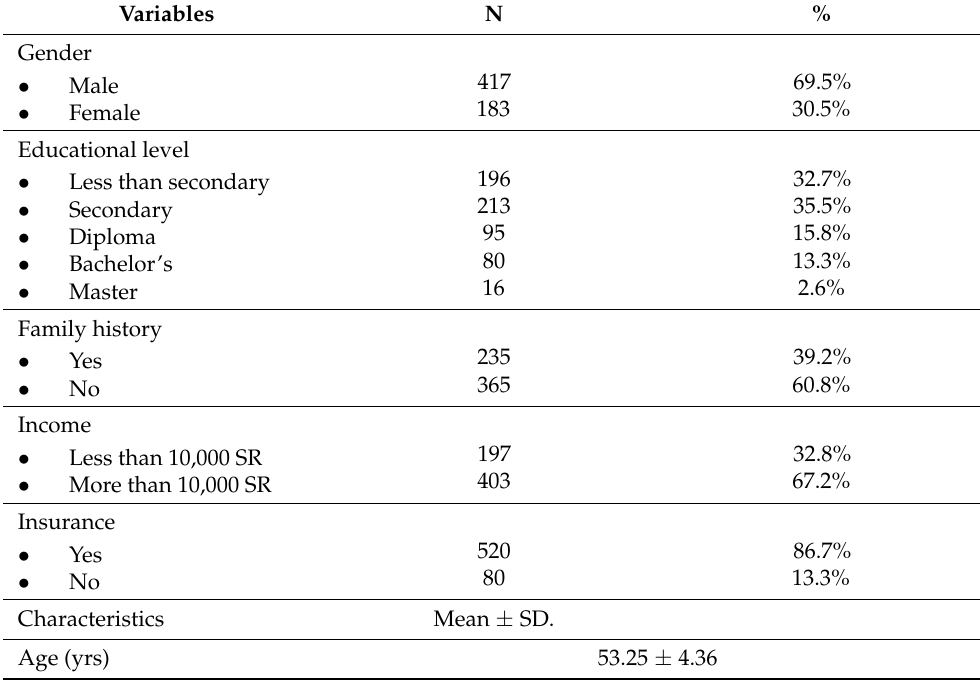
Table 2. Sample Socio-demographics (N = 600).